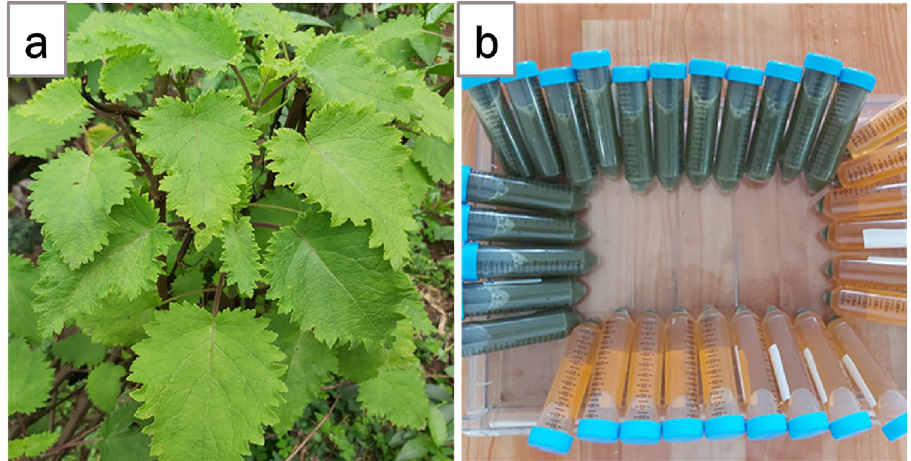
Figure 1. Image of ( a ) Tetradenia riperia plant leaves ( b ) uncentrifuged and centrifuged aqueous leaves